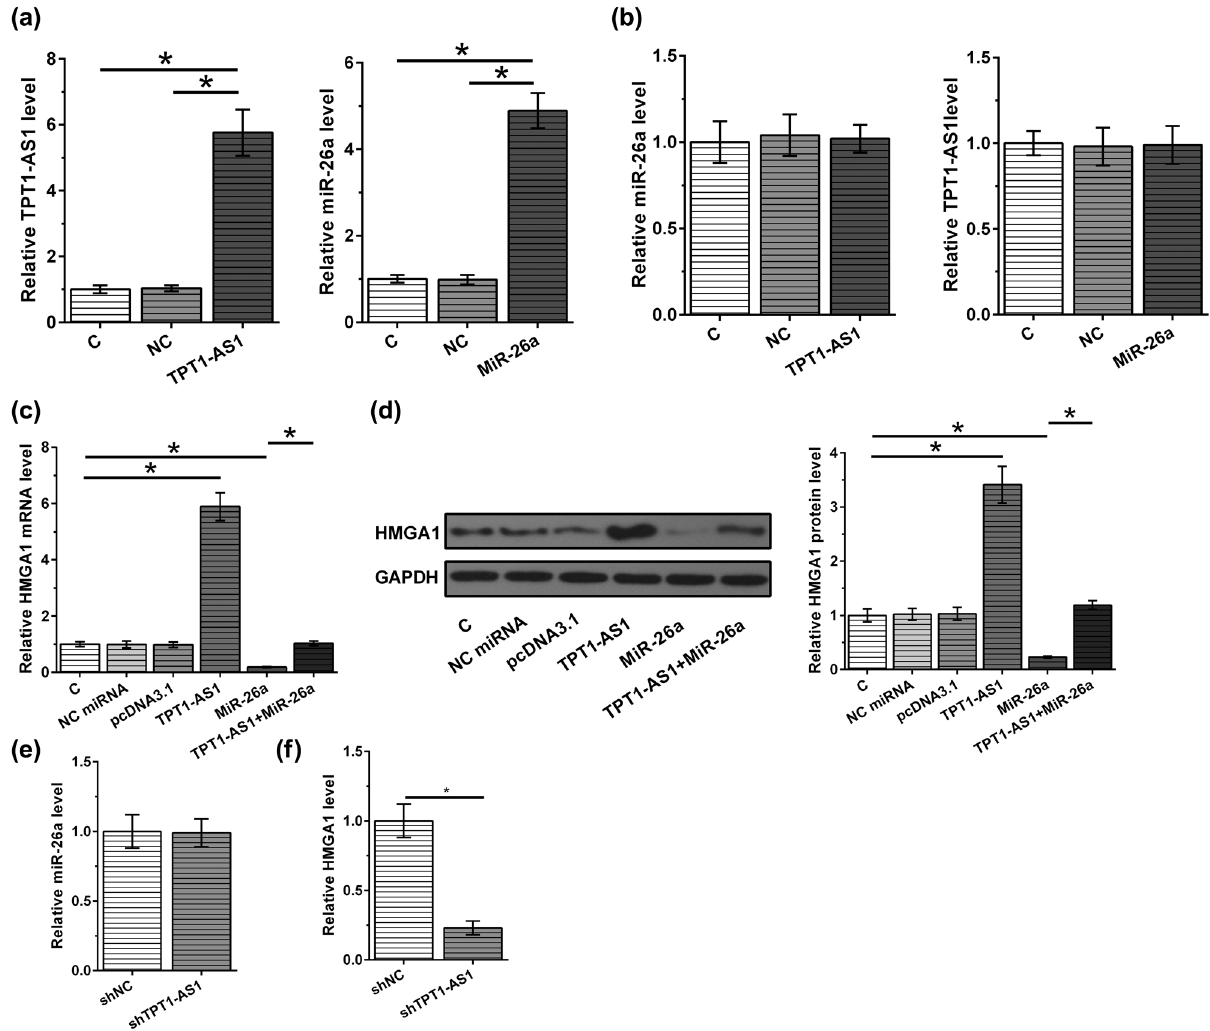
Figure 4: TPT1 - AS1 enhanced HMGA1 expression by sponging miR - 26a. TPT1 - AS1 expression vector and miR - 26a mimic were transfected into KYSE510 cells. ( a and b ) TPT1 - AS1 and miR - 26a levels were assessed by RT - qPCR. ( c and d ) HMGA1 expression level was assessed by RT - qPCR and western blotting. ( e and f ) The expressions of miR - 26a and HMGA1 were assessed by RT - qPCR in KYSE510 cells transacted with shTPT1 - AS1. *, p <